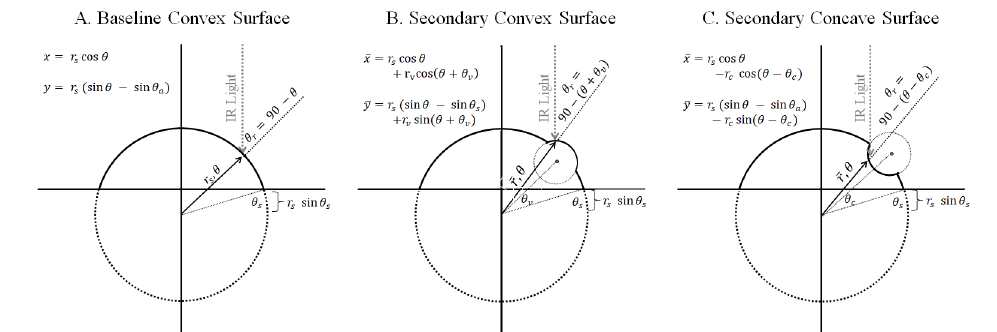
Figure 3. Facial surface reflectance models. Model A is the baseline convex surface. Model B introduces a secondary convex surface, increasing reflectivity and phase. Model C introduces a secondary concave surface, decreasing reflectivity and